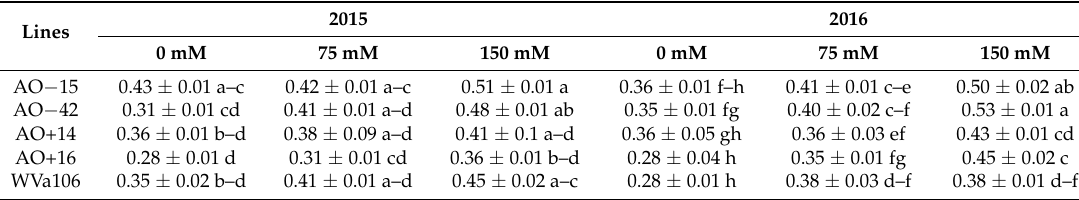
Table 5. Firmness (N) of lines with low or elevated AO activity and non-transgenic line of red-ripe cherry tomato fruits under two salinity levels (75 and 150 mM NaCl) in 2015 and 2016. Results with the same letter were not significantly different ( p < 0.05) according to the classification obtained by the Duncan